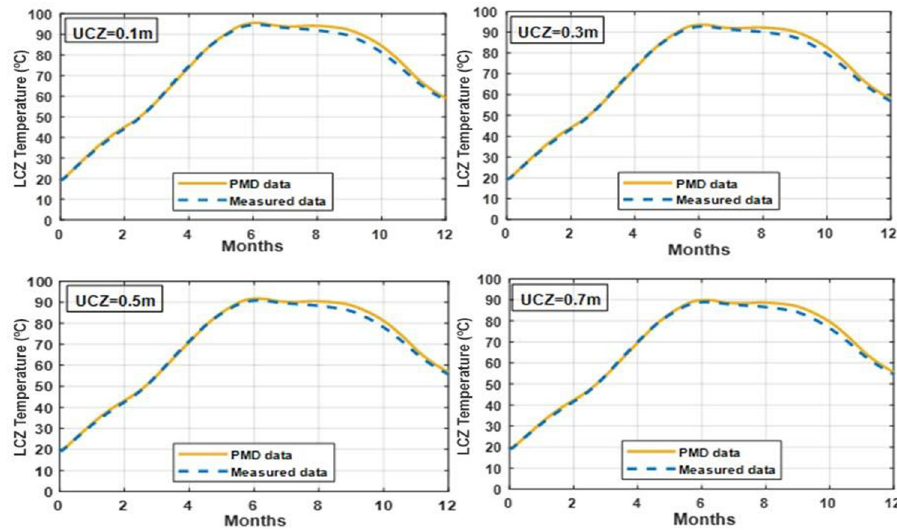
Fig 12. Effect of different thickness UCZ on the temperature of LCZ with NCZ = 1 m and LCZ = 0.7 m under PMD and measured climatic conditions of Islamabad.